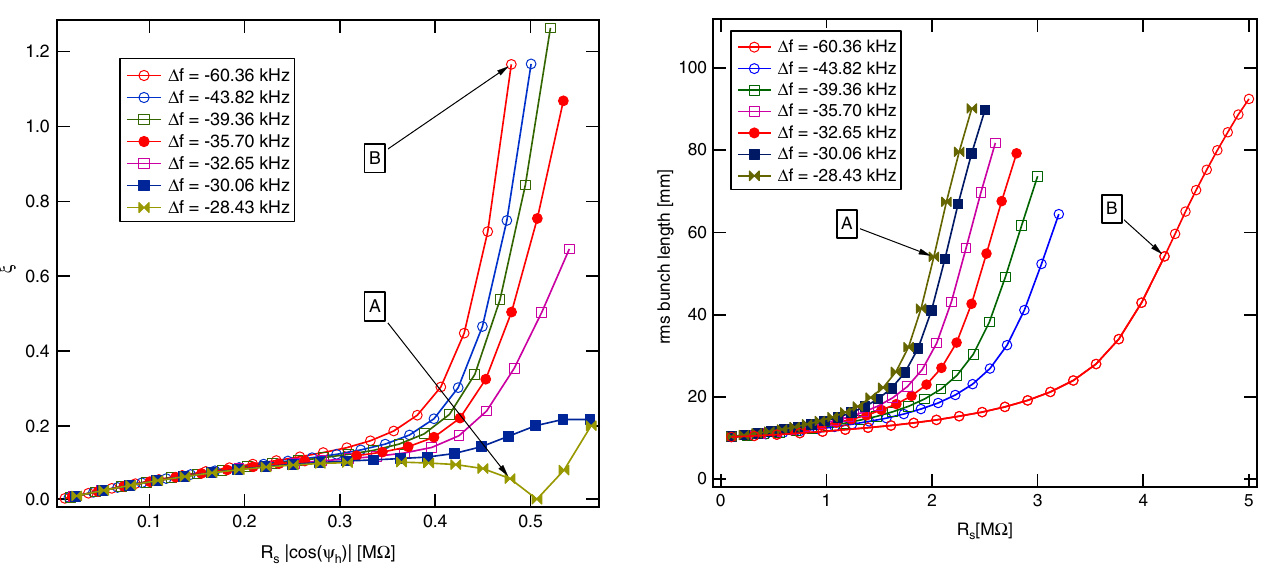
FIG. 3. Difference ξ between self-consistent and scalar solu- tions to the bunch density distribution as a function of R for various values of harmonic cavity detuning. The points identified by A and B correspond to the cases displayed in the plots of Fig. 1 and Fig. 2, respectively.